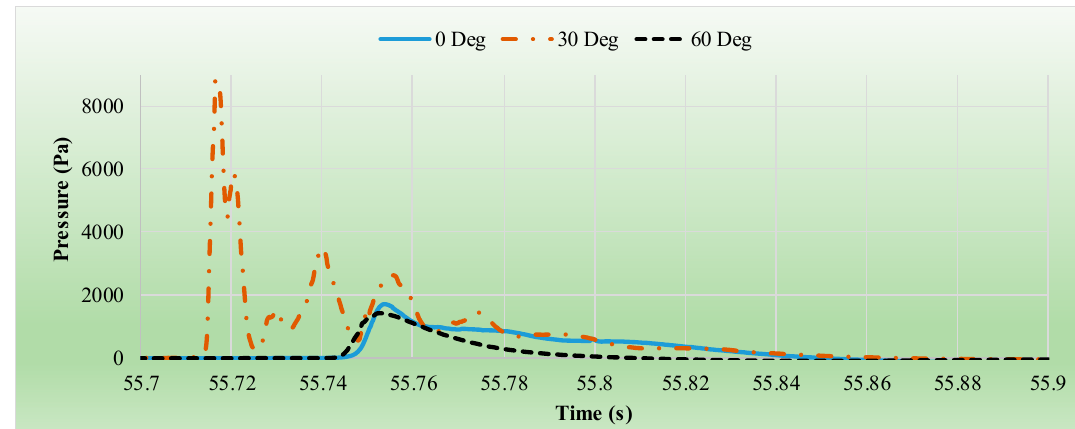
Figure 15. Comparison of pressure at the corner of the tank (sensor location K) with 100 mm water depth excited by resonance frequency at: 0°, 30°, and 60° orientations.